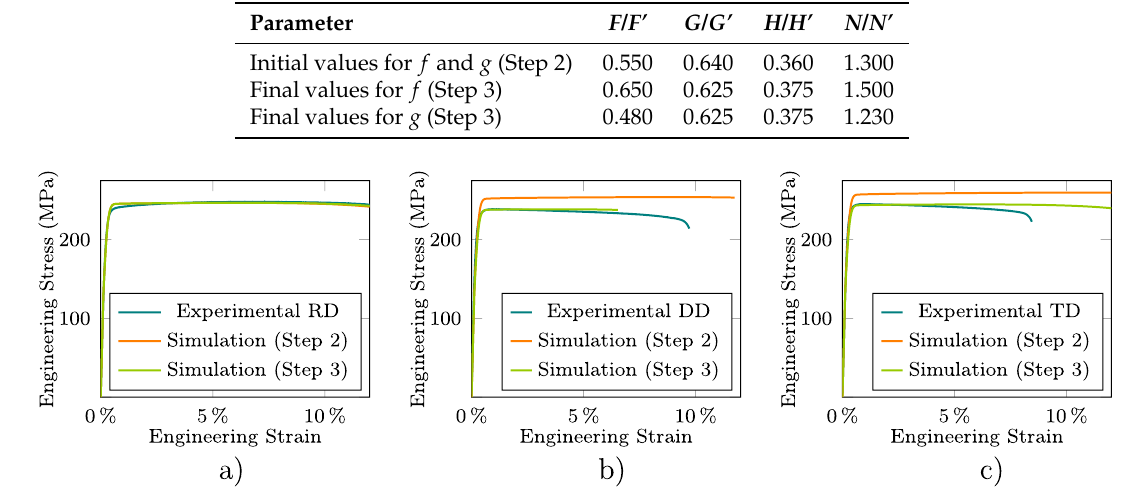
Figure 8. Fitting of the Hill-48 yield and flow potential functions from the average experimental ε w – ε l curve for the ( a ) RD, ( b ) DD, and ( c ) TD tensile samples at the central point of the neck.